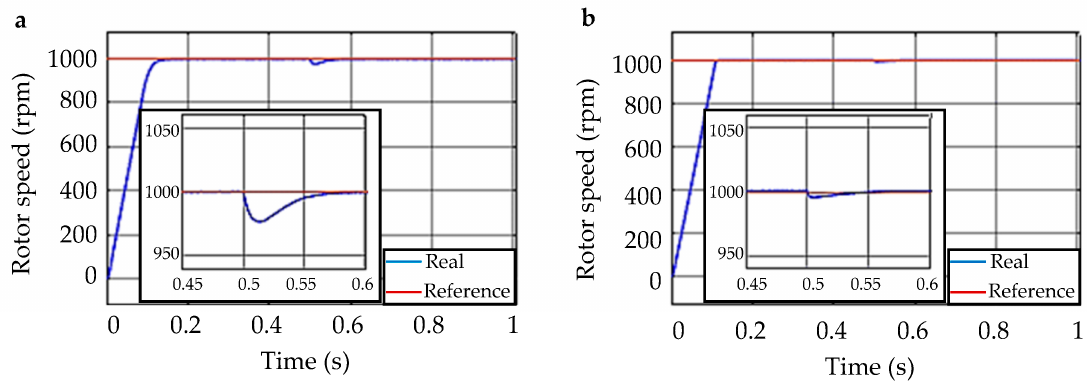
Figure 11. Response of speed under load during startup and steady state.